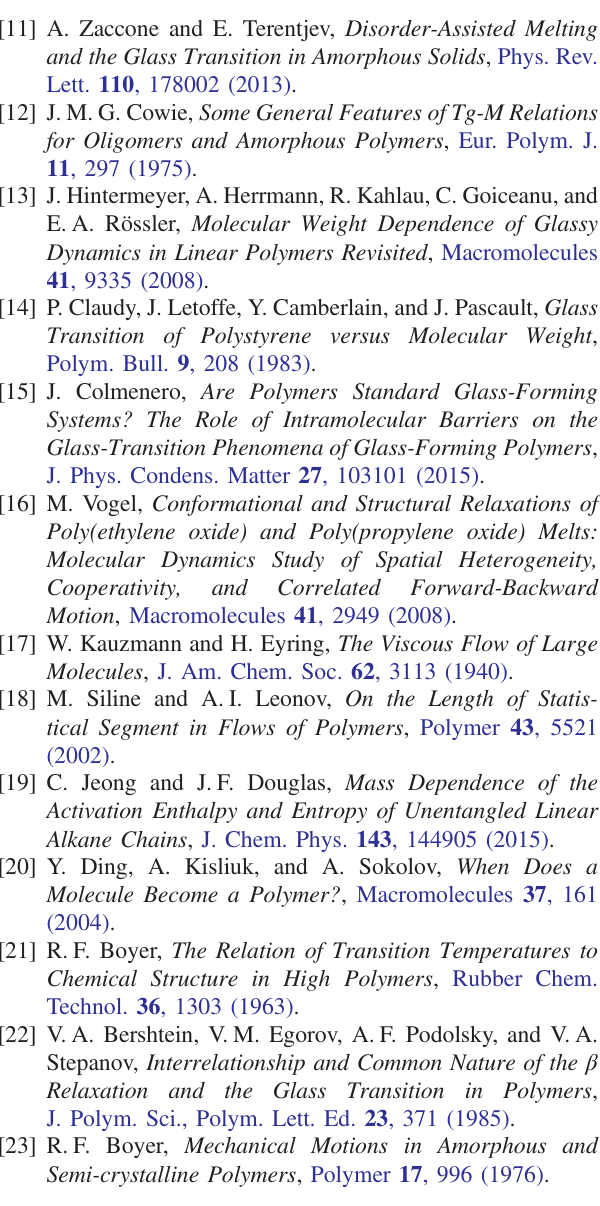
, polydispersity index (PDI= M w